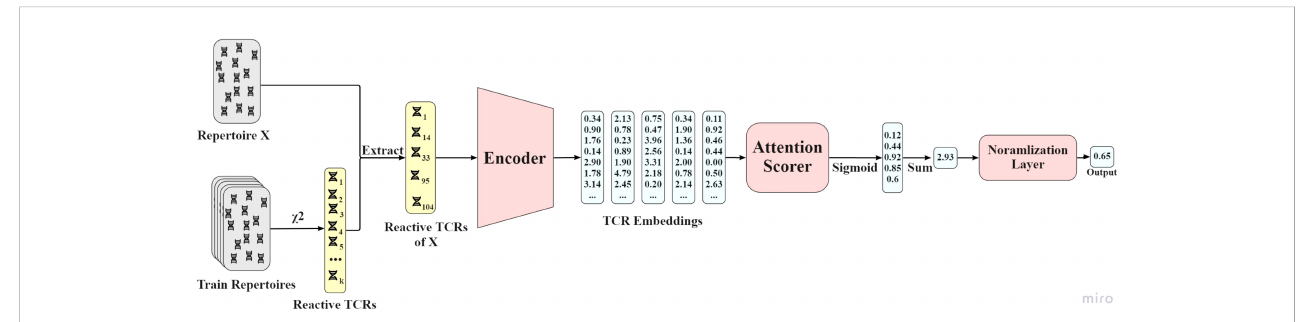
FIGURE 7 AttTCR ’ s architecture. First, the reactive TCRs are sampled from all the train repertoires using the c 2 method. Then, for each repertoire X , the reactive TCRs contained in X are extracted. Each reactive TCR is projected by the encoder. The projections are then scored by the attention scorer. The scores are summed and normalized. The output of the model is a number between 0 and 1 that indicates the con fi dence of the model on whether the repertoire is